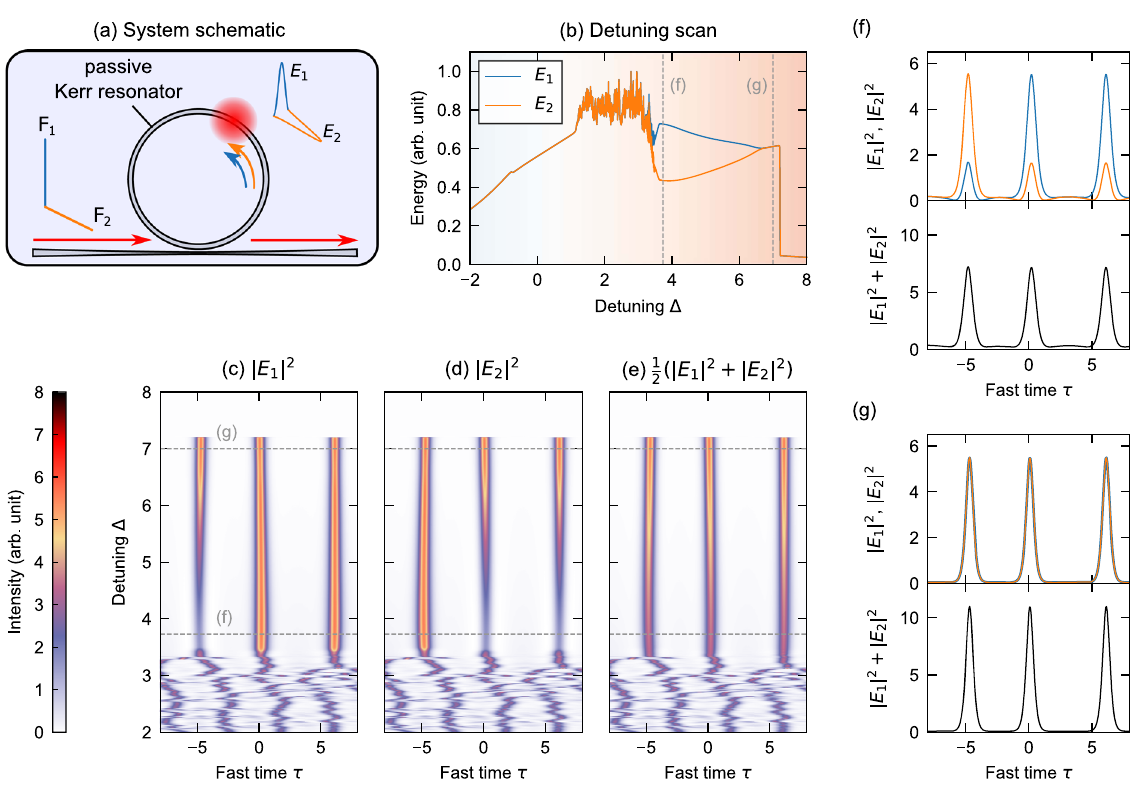
Fig. 1 Concept and illustrative numerical simulations. a Schematic illustration, showing a passive Kerr resonator whose two orthogonal (polarization) eigenmodes are symmetrically excited. b Numerical simulation results, showing the evolution of the integrated intracavity energy contained in cavity mode E E Δ is linearly increased. The energies part at the “ soliton step ” , revealing SSB. c , d Evolution of the 1 (blue curve) and 2 (orange curve) as the detuning intracavity temporal intensity pro fi les corresponding to modes E 1 and E 2 , respectively, as the detuning is changed; e shows the corresponding evolution of the total intensity. f , g Top panels show snapshots of the modal intensity pro fi les at detunings indicated with gray dashed lines in ( b ) – ( e ), whilst the bottom panels show the corresponding total intensity. All the results shown were extracted from the same numerical simulation with total driving intensity X = 4.5 and cross-coupling coef fi cient B = 1.6 similar to the experiments that follow. The colorbar represents the full modal intensities in ( c ) and ( d ) and half of the total intensity in ( e